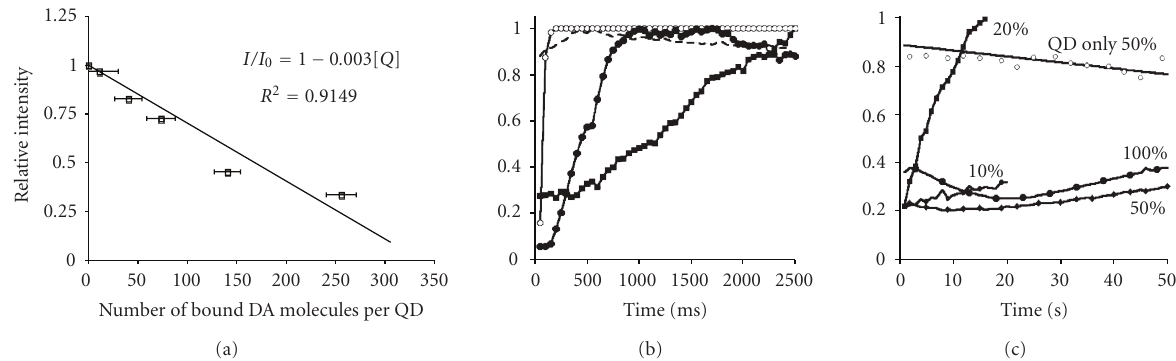
Figure 3: Relationship between the number of dopamine molecules bound to the surface of QD605 and the resulting emission intensity. (a) The quenching observed upon conjugation is nearly logarithmic. Data are an average of three experiments with error bars indicating the standard error of the mean. (b) Unquenching of QD-dopamine conjugates with varying amounts of coverage under Hg-lamp exposure (QD filter set, see Methods). Each symbol is a data point, with error bars smaller than symbols ( n = 3). Bare QDs alone (dashed line) show essentially constant fluorescence over a 2.5-second exposure period; they begin to photobleach near the end. QDs, to which dopamine was added but not conjugated (no EDC) (open circles), achieve maximum fluorescence within 50 milliseconds. Conjugates with 40 ± 14 DA/particle (filled circles) brighten over a time course of ∼ 700 milliseconds. The conjugates with the greatest coverage (filled squares, 255 ± 14 DA/particle) have just begun to plateau at 2.5 seconds. (c) Confocal laser illumination of samples with 255 ± 14 DA/particle. Photoenhancement showed a strong dependence upon laser power, with e ffi cient enhancement at 20% but limited or no enhancement at 10%, 50%, and 100% power. Each symbol is a data point, with error bars smaller than symbols ( n = 5). Unconjugated QDs showed similar bleaching curves for all powers tested (shown: